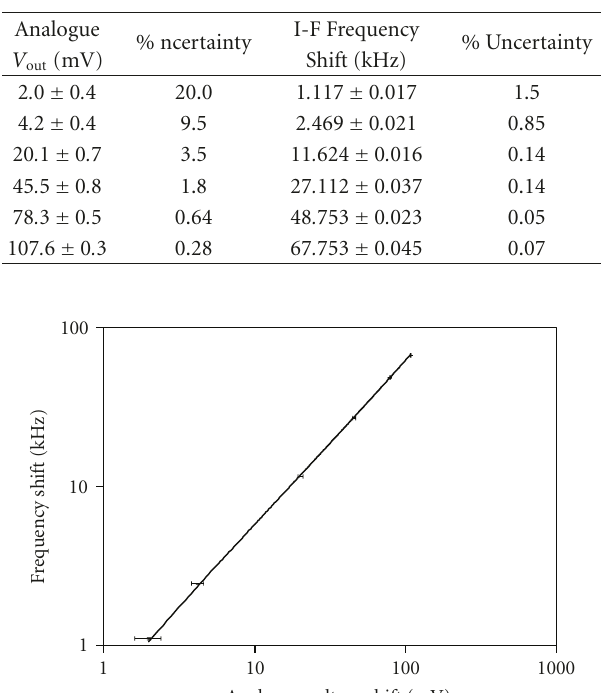
Table 1: Analogue output and corresponding frequency shift from A/D conversion using a low level light source into a PIN 5DPI